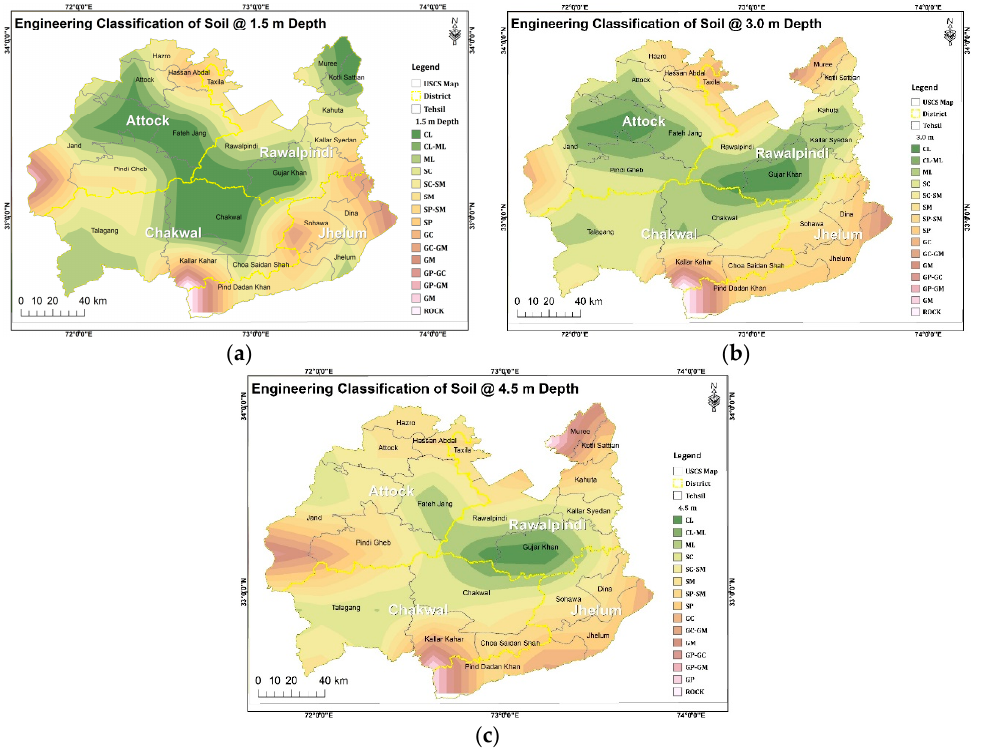
Figure 8. ( a ) Engineering Classification of Soil at 1.5-m Depth; ( b ) Engineering Classification of Soil at 3.0-m Depth; ( c ) Engineering Classification of Soil at 4.5-m Depth. 3.0-m Depth; ( c ) Engineering Classification of Soil at 4.5-m